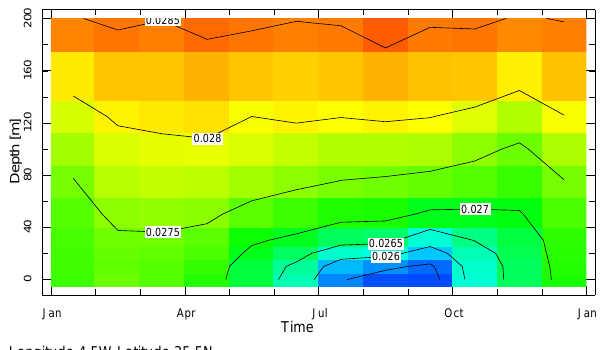
Fig. 6. Monthly potential density for the Alboran Sea (35 . 5 ◦ N, 4 . 5 ◦ W) (Levitus, 1994).